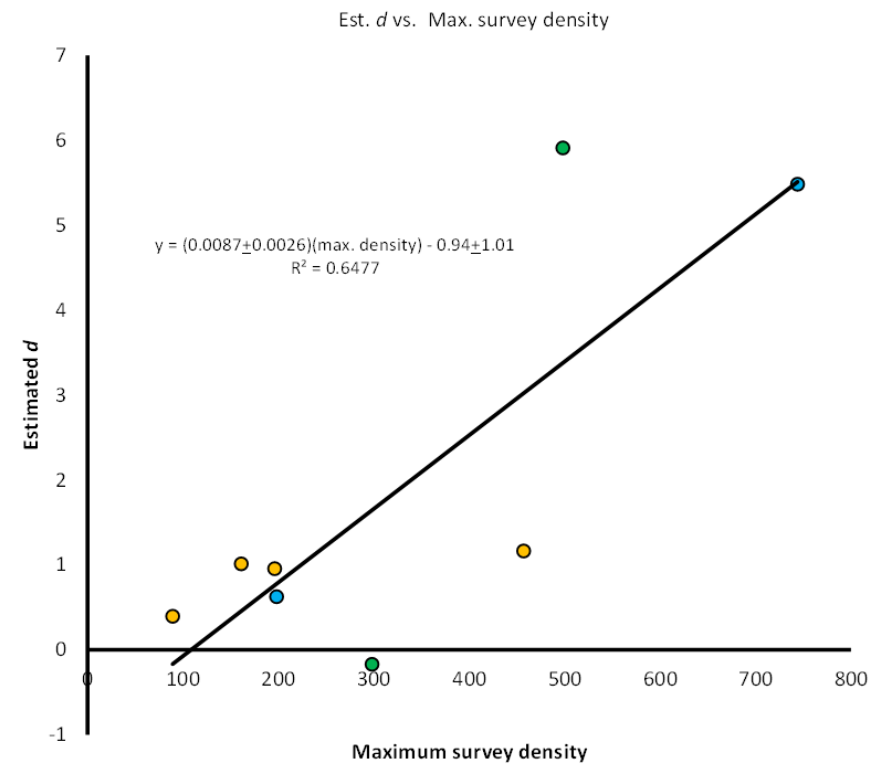
Figure 6. Regression of estimated value of parameter d plotted against maximum number of larvae in a container for each experiment. d = − 0.94 ± 1.01 + 0.0087 ± 0.0026 (Max. survey density) r 2 = 0.6477. Point colors indicate target species, and reproduce the colors used in Figures 2–5: Green = Ae. triseriatus ; Blue = Ae. albopictus ; Orange = Ae. aegypti.